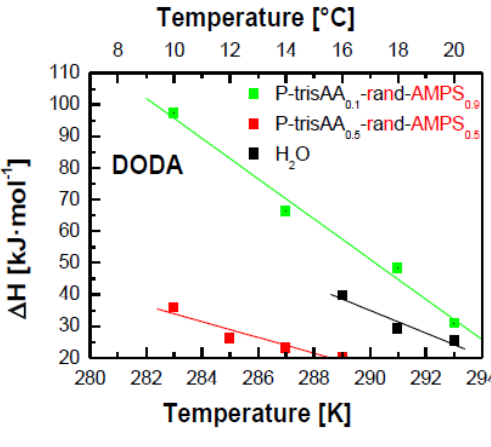
–rand–AMPS ( x = 0.1 green, 0.5 red) in the subphase. x 1 − x –rand–AMPS is 0.01mmol/L in monomer x 1 − x